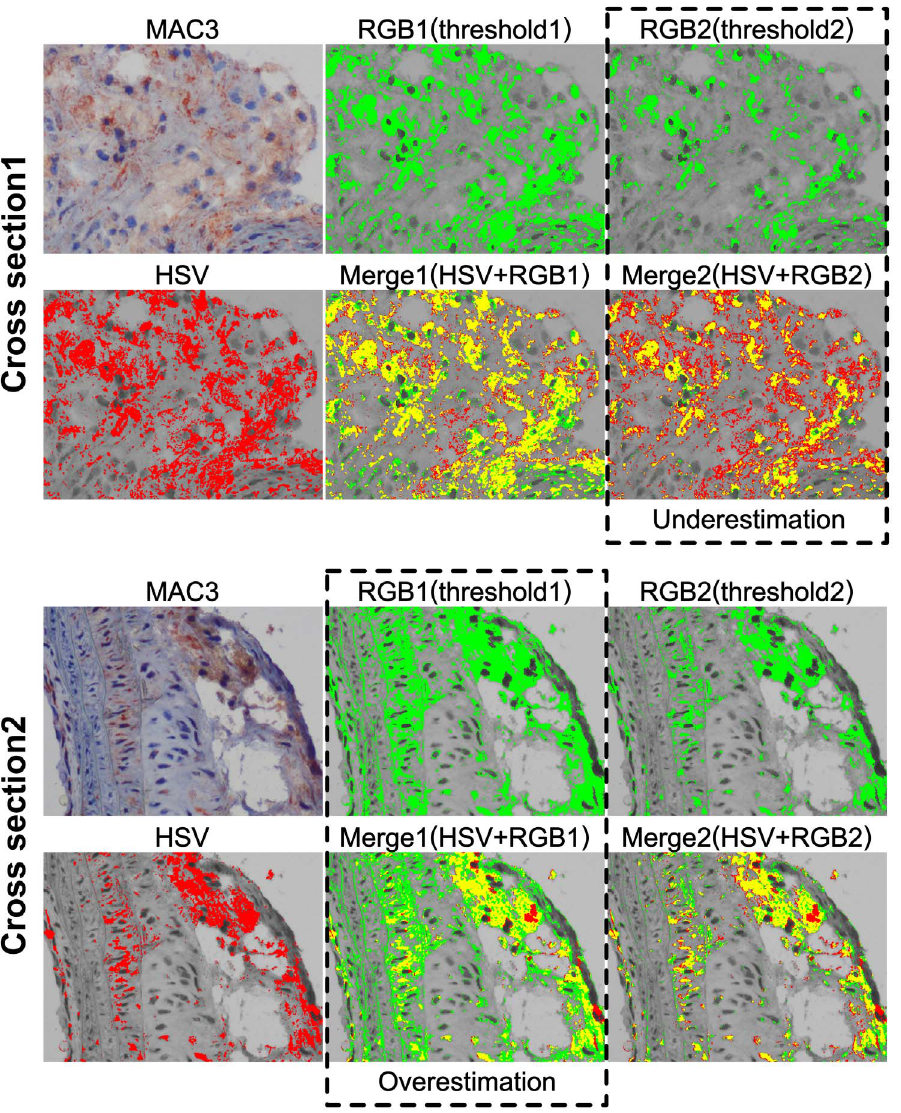
Figure 4. CSH is consistent between individuals. Apoe 2 / 2 mouse innominate arteries stained with MAC3 antibody for detection of macrophages. RGB1(threshold1) was optimized for Cross Section 1, and overestimates the positive area when applied to Cross Section 2. RGB2(threshold2) was optimized for Cross Section 2, and underestimates the positive area when applied to Cross Section 1. CSH was able to effectively use a single HSV threshold on both cross sections. In the overlays between the HSV and RGB1 and RGB2, yellow area shows where there is agreement between the HSV method and the RGB method. Green area in the overlays may indicate false positive area reported by the RGB method, while red area in the overlays may represent false negative area reported by the RGB